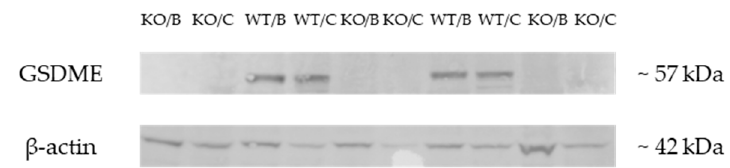
Figure 2. Representative example of a Western Blot on samples of Gsdme KO and WT mice. Western Blotting was performed with a primary rabbit anti-DFNA5/GSDME-N-Terminal antibody (ab215191) and a secondary Goat Anti-Rabbit IgG (H+L)-HRP Conjugate (#1706515). Clear GSDME protein bands ( ~ 57 kDa) were seen, both in the brain and colorectal tissue of WT mice. GSDME could not be detected in Gsdme KO brain or colorectal tissues. In all samples, clear bands for β -actin could be seen ( ~ 42 kDa). WT = wild type mice; KO = Gsdme knockout mice; B = brain tissue; C = colorectal tissue .